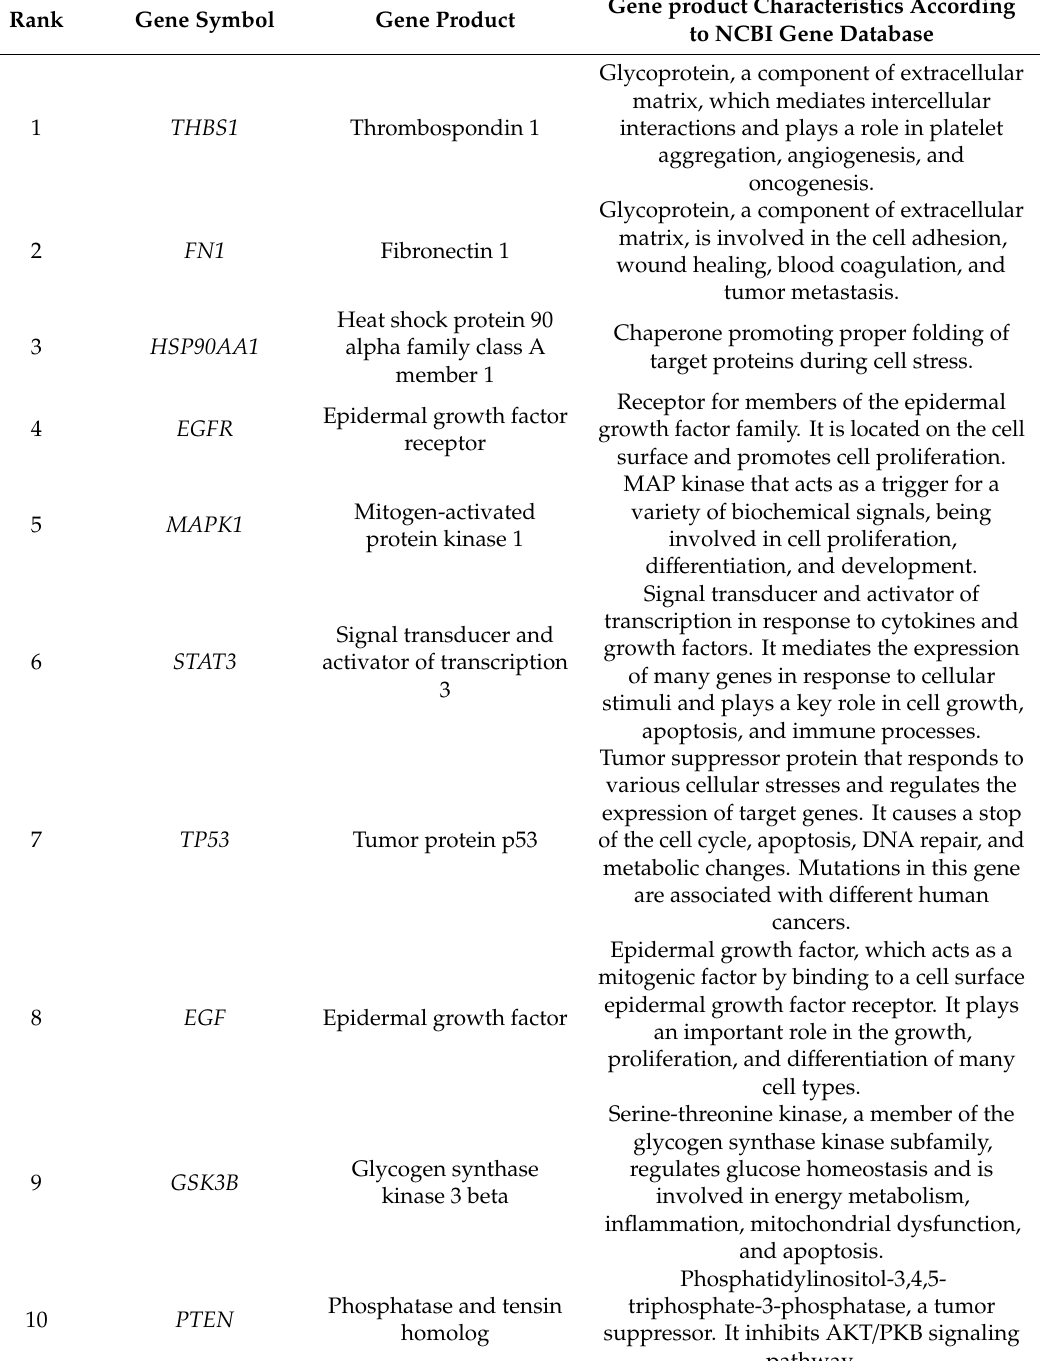
Table 5. Top ten candidate genes potentially related to